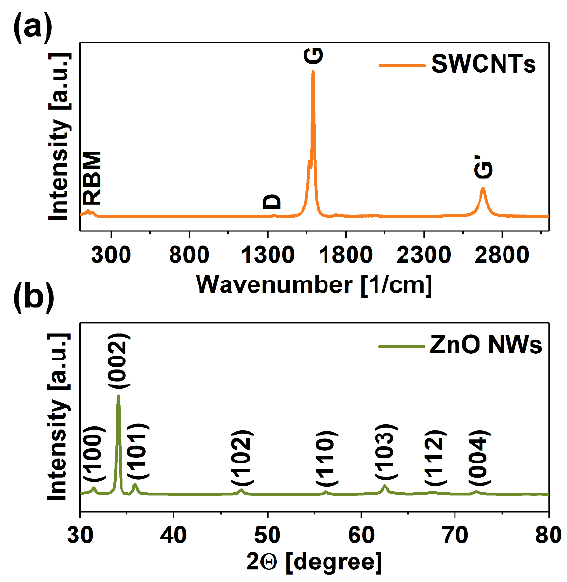
Figure 2. ( a ) Raman spectrum of SWCNTs and ( b ) XRD patterns of ZnO NWs used in the study.